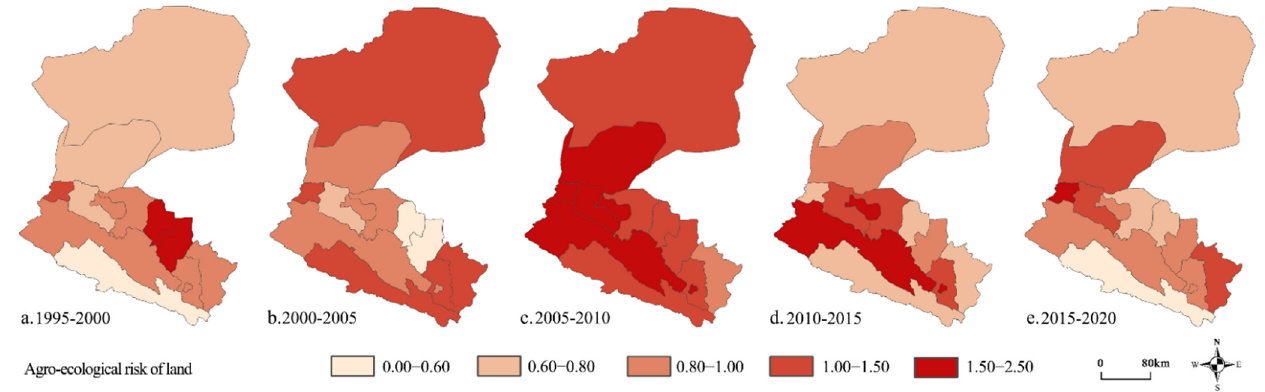
Figure 3. Agroecological risk of land by district and county in the HRB over time.